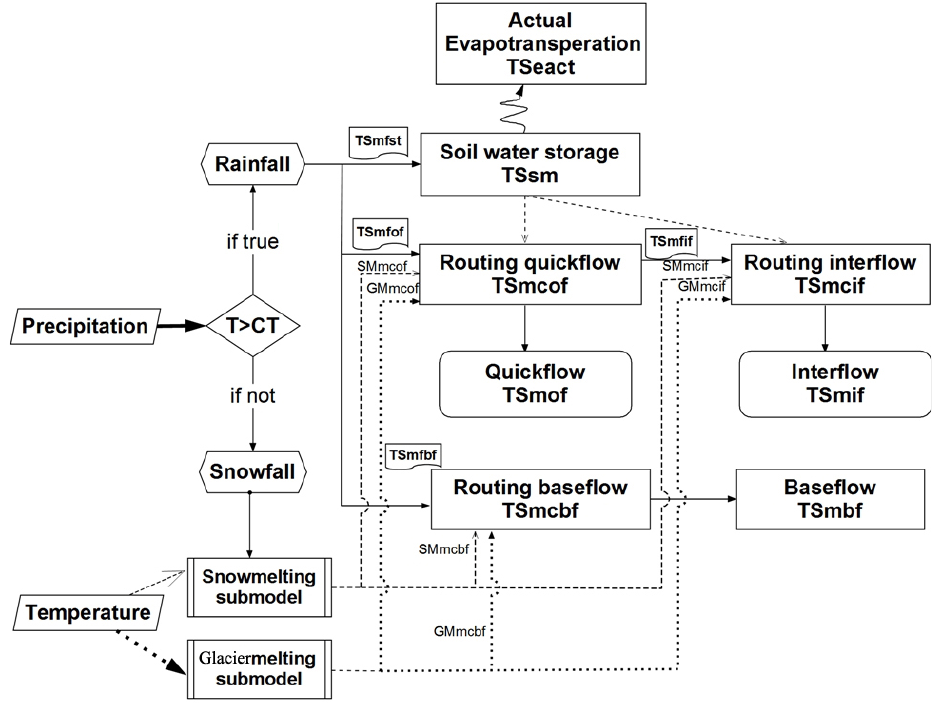
Fig. 3. The lumped conceptual rainfall-runoff model structure, including seasonal snow melting and glacier